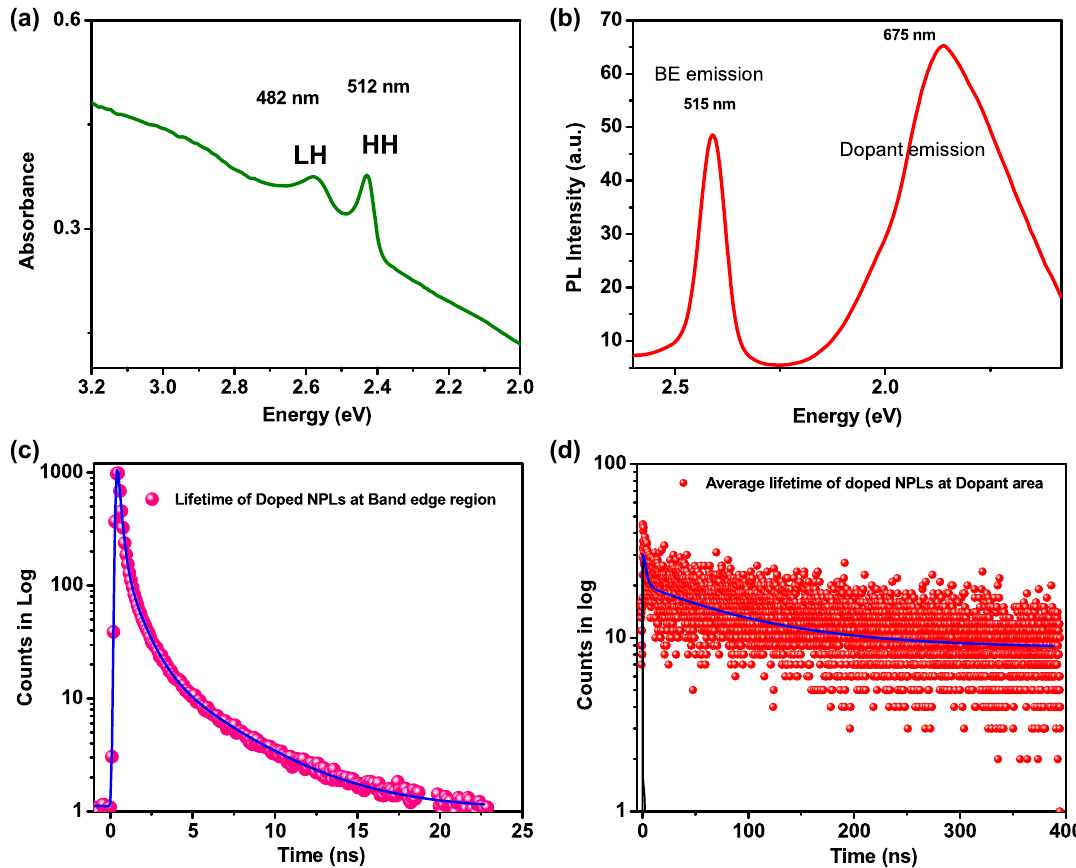
Figure 2: Optical characterization of the doped NPLs; (a) UV-vis and (b) photoluminescence (PL) spectrum of Cu-doped CdSe NPLs, (c) average decay profile of doped NPLs at band edge emission area, and (d) average decay profile at dopant emission